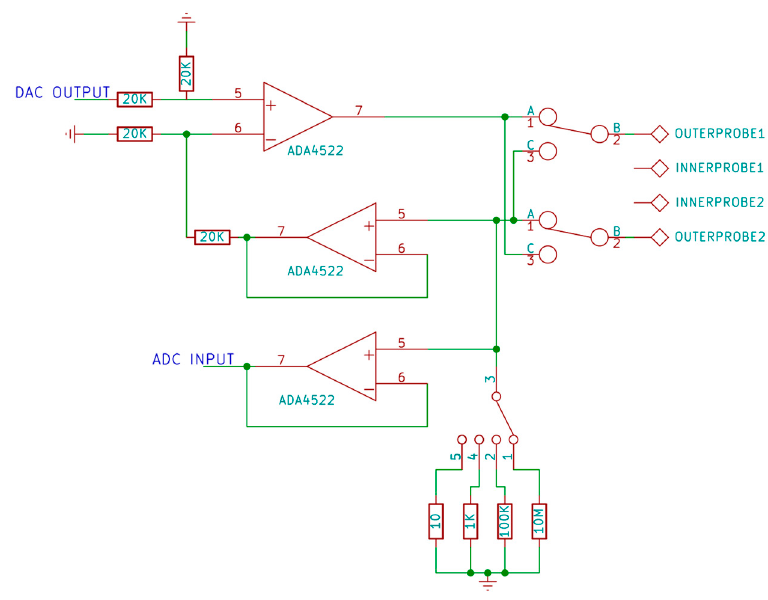
Figure 5. Current source circuit.